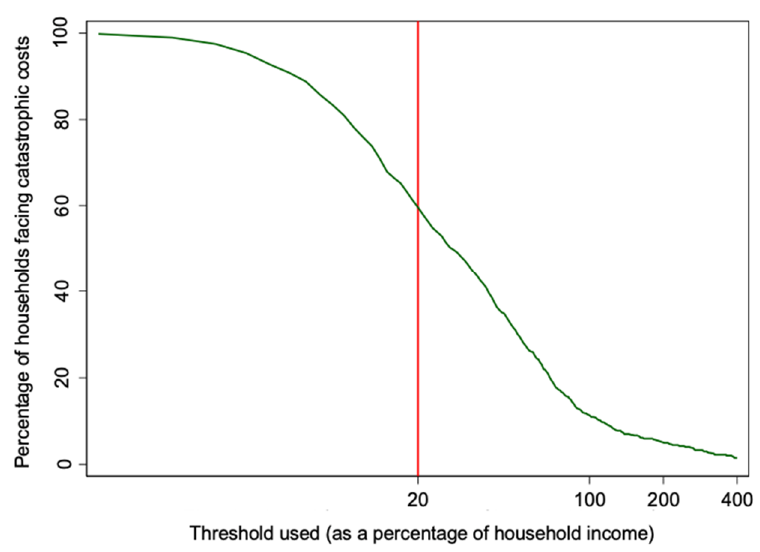
Figure 2. Sensitivity analysis of threshold used for determining catastrophic costs (output ap- proach).